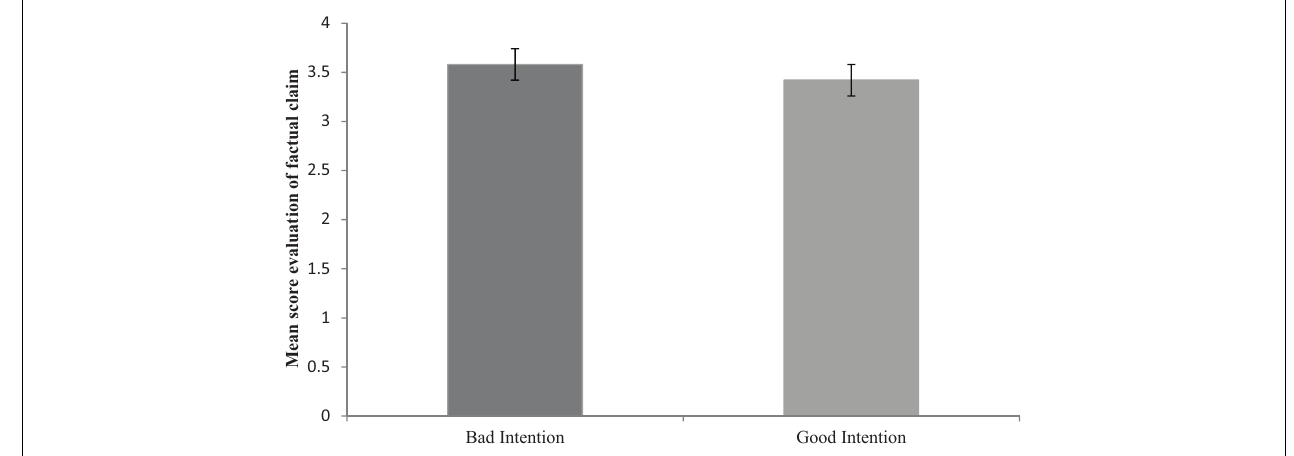
FIGURE 2 | Mean score of children’s evaluation (from 0 = very good to 4 = mean). Error bars depict standard error of the mean. TABLE 3 | Frequencies (percentage) of justifications.